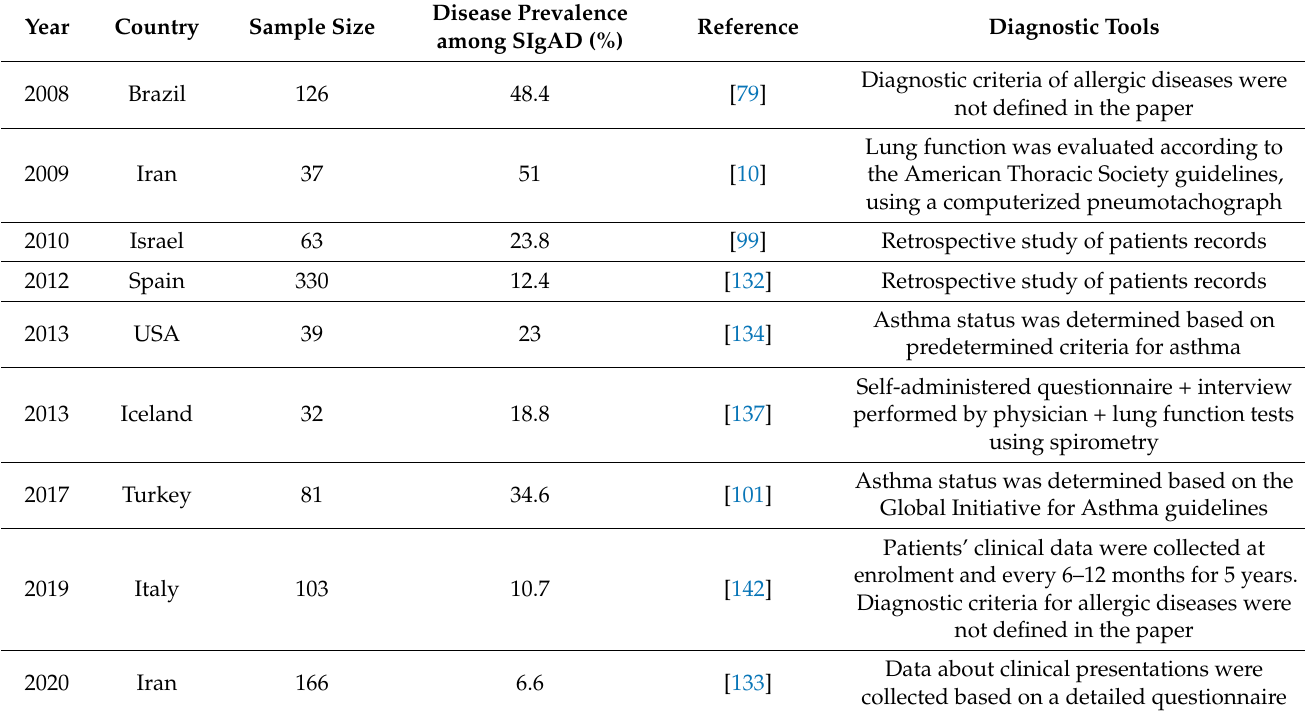
Table 2. Asthma and